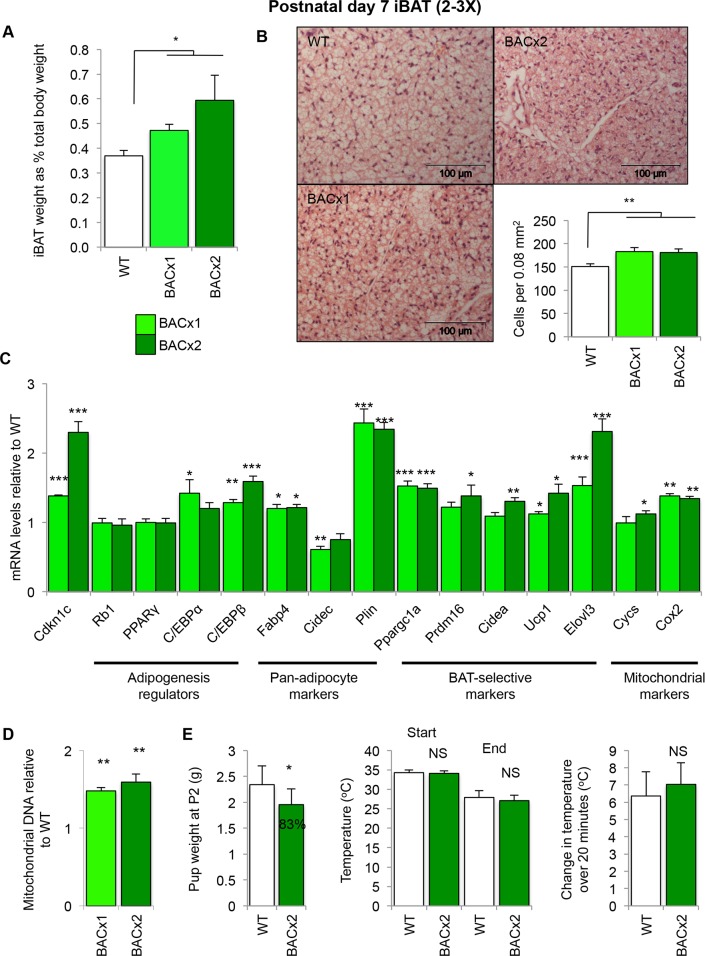
Elevated Cdkn1c boosts the formation of classic BAT in young mice.(A) Weights of WT, BACx1 and BACx2 iBAT relative to total body weight (WT n = 20, BACx1 n = 18, BACx2 n = 8). (B) H&E staining of P7 iBAT depot sections from WT, BACx1 and BACx2 pups (WT from line BACx1) and cell counting data (n = 6 per genotype). (C) QPCR of Cdkn1c, adipogenesis regulators, thermogenic, BAT-selective and mitochondrial genes in BACx1 and BACx2 P7 iBAT relative to WT (n = 4 per genotype). (D) Quantitation of mitochondrial genomic DNA of BACx1 and BACx2 iBAT relative to WT (n = 6). (E) Surface body temperature of BACx2 P2 pups relative to WT littermates was assessed by thermal imaging (WT n = 19, BACx2 n = 8) within 1 minute of removal from nest temperature (33°C; approaching thermoneutrality) and after 20 minutes at room temperature (22°C). Data expressed as mean ± SEM, t test. * P <0.05; ** P <0.01; *** P <0.005.